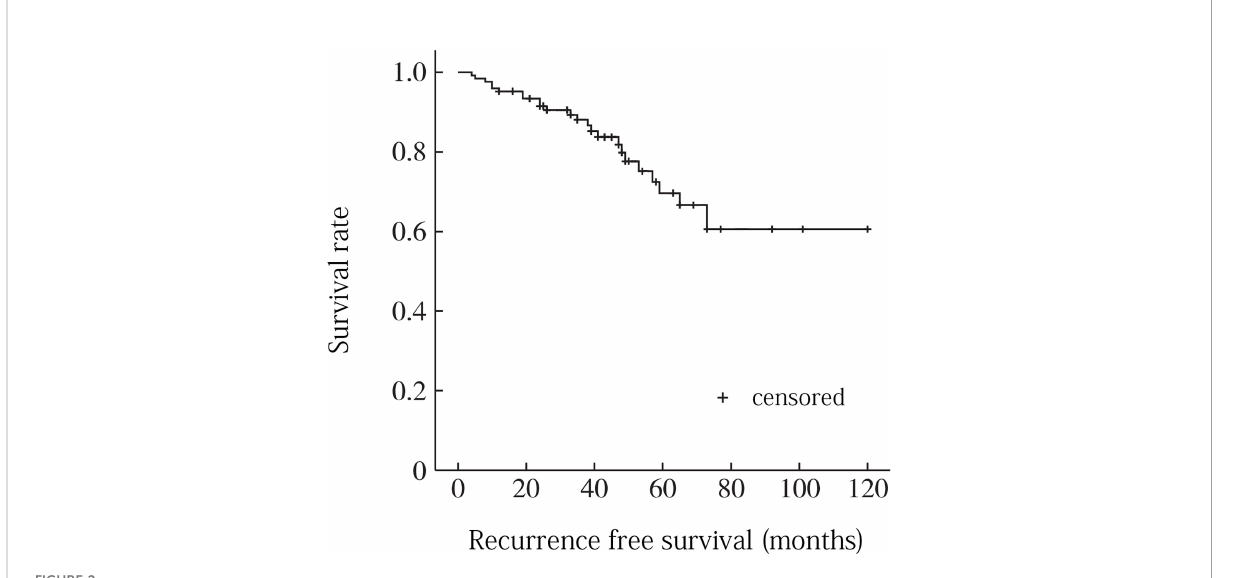
FIGURE 2 Overall recurrence-free survival curve for sacrococcygeal